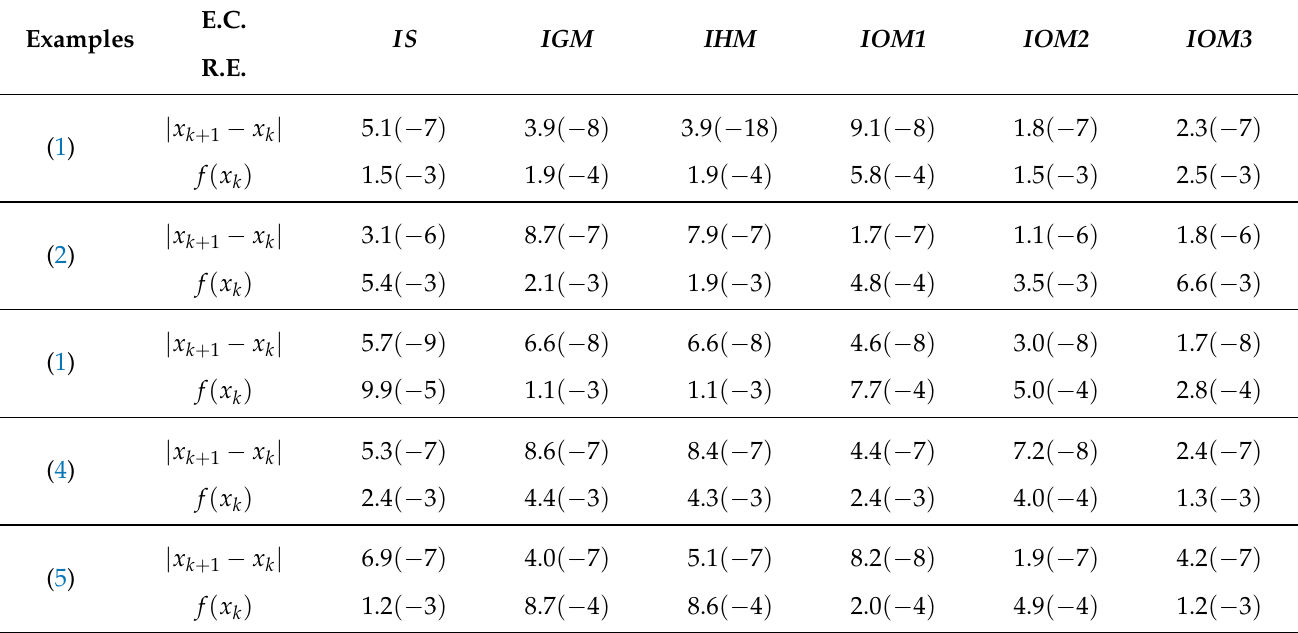
Table 3. Comparison of our methods with existing Ishikawa method based on k = 12 number of iterations.